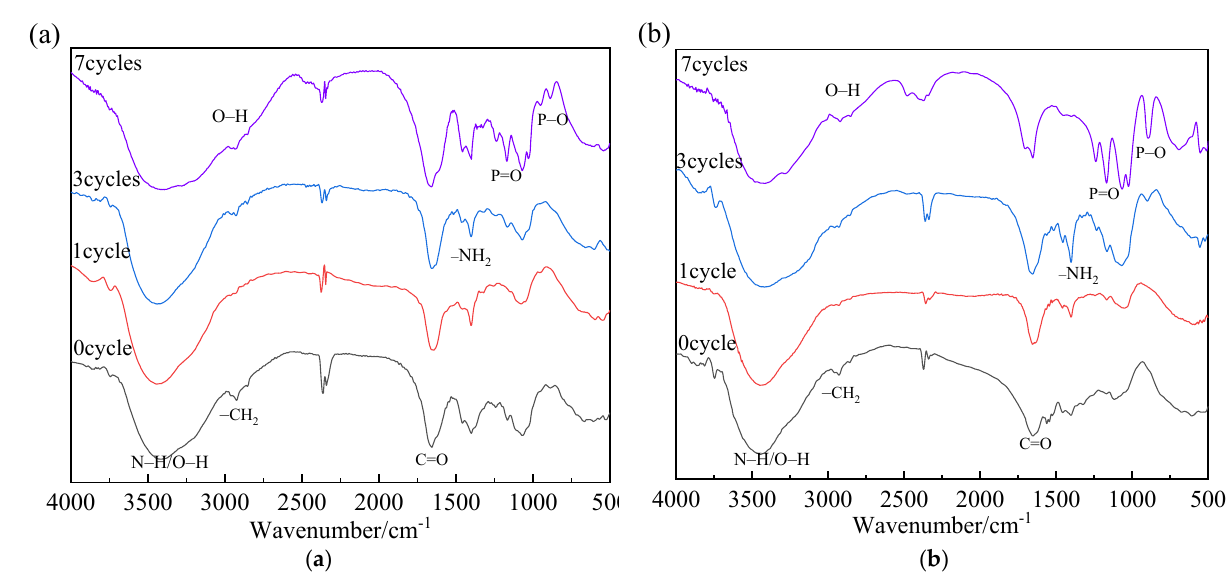
Figure 13. FTIR spectra of C ‐ 0 sample ( a ) and C ‐ 1 sample ( b ) after different aging cycles. As shown in Figure 13b, compared to the PAM hydrogel of sample C ‐ 0, the intensity of the C=O group at 1672 cm − 1 in the C ‐ 1 sample becomes slightly stronger with the increase of aging cycles because the high stablity of carboxylates and carboxylic acids [28], indicating the excellent anti ‐ aging properties of the C ‐ 1 sample. The stretching vibration peak of NH 2 at about 1400 cm − 1 first increases and then decreases during the aging test, which corresponds to the degradation of the polymer chain and the decomposition of the polyacrylamide respectively. The peak intensities of O–P=O and P–O groups at about 1300 and 900 cm − 1 gradually increase during the aging test, which is ascribed to the precipitation of the flame retardants. The stretching vibration peak of C–O groups at 1150 cm − 1 in P(AM ‐ co ‐ AA) hydrogels gradually strengthens with the increase of aging cycles, which is consistent with the trend of heat insulation performance and light transmittance.